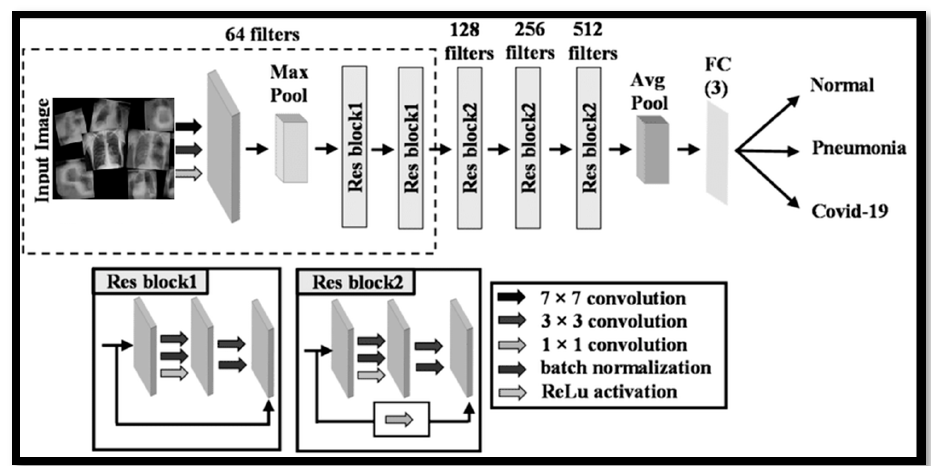
Figure 5. RESNET.